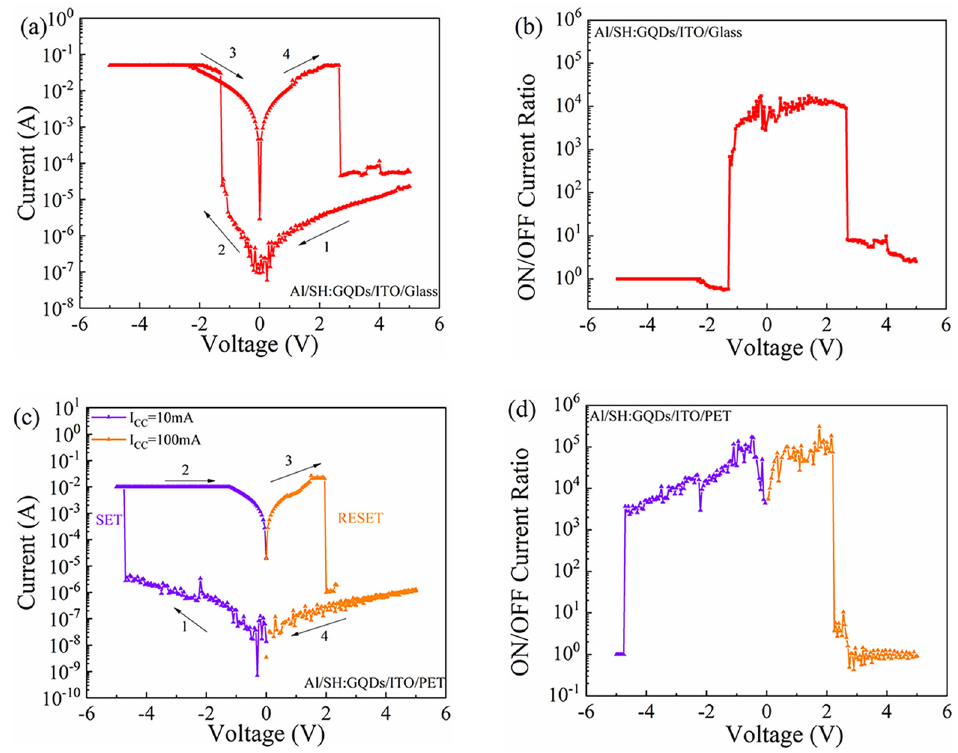
Figure 5. Al/SH:GQD/ITO/glass device: ( a ) I-V characteristic curve and ( b ) ON/OFF current ratio. Al/SH:GQDs/ITO/PET device: ( c ) I-V characteristic curve and ( d ) ON/OFF current ratio.